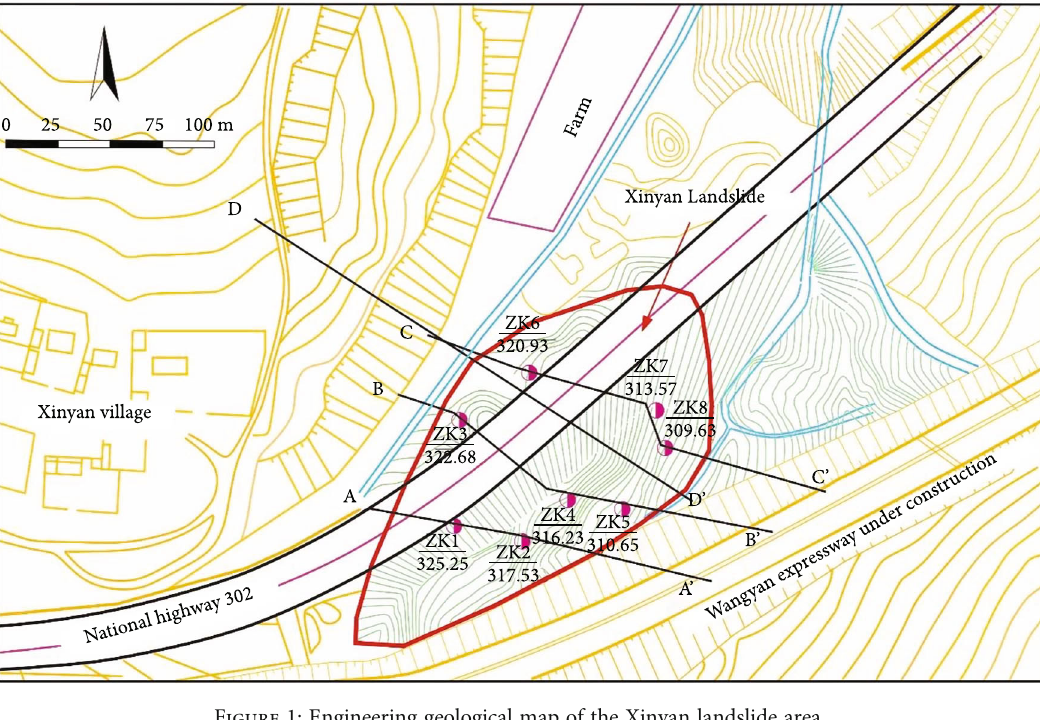
Figure 1: Engineering geological map of the Xinyan landslide